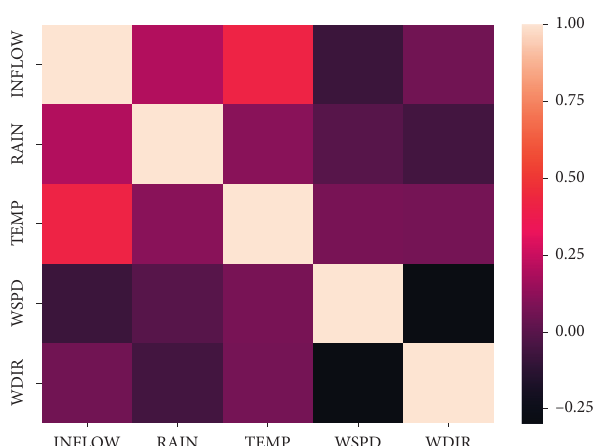
Figure 8: The correlation analysis of inflow and environmental